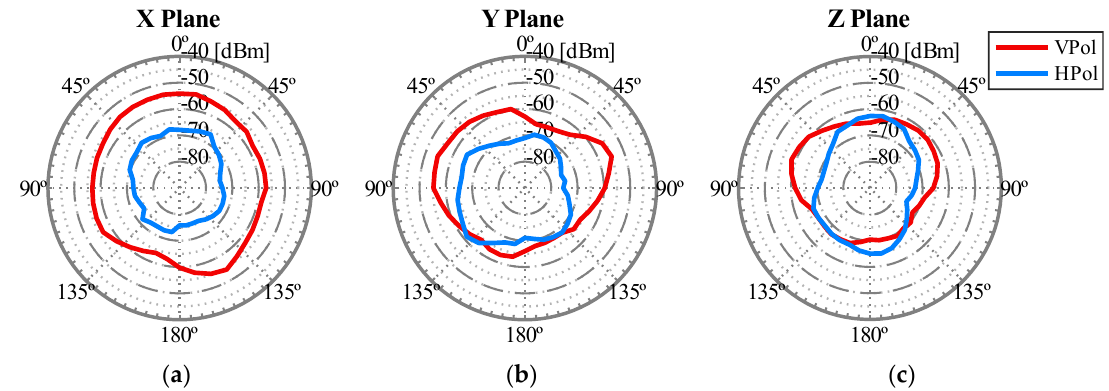
Figure 18. Radiation pattern of the WiTi on-board the UAV for the antennas configuration shown in Figure 13 in the U2U link working in 5 GHz: ( a ) X Plane, ( b ) Y Plane, and ( c ) Z Plane.